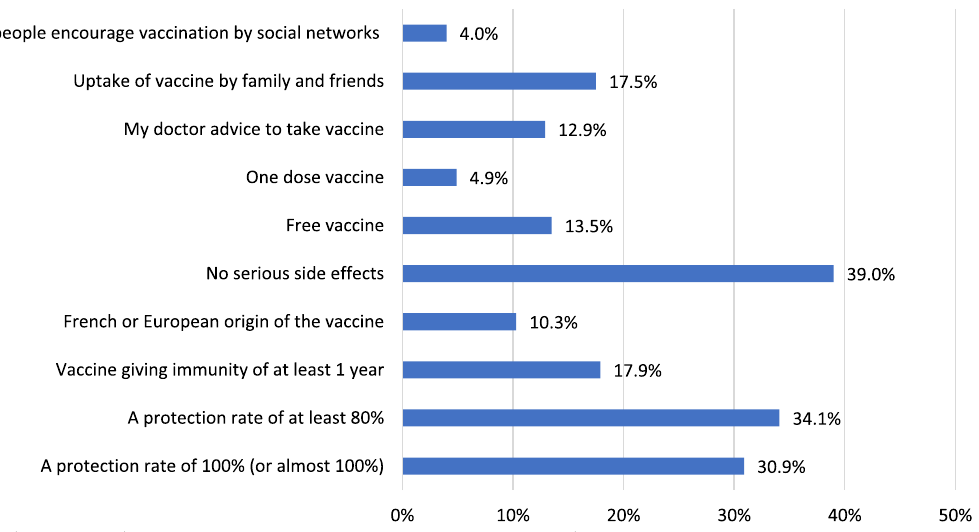
Fig. 6 Reasons for change towards intention to get COVID-19 vaccination among vaccine hesitant group ( n